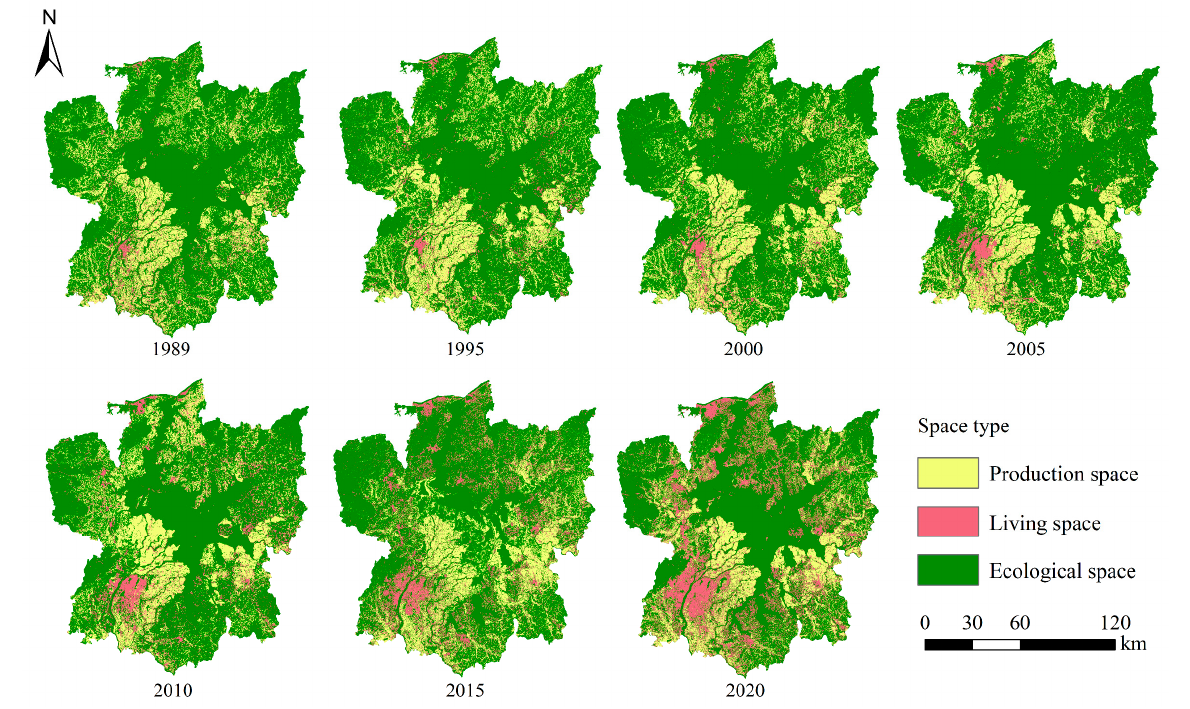
Figure 5. Spatial classification map of PLE space in the PYL area from 1989 to 2020. Table 5. Spatial transfer matrix in the PYL area from 1989 to 2020 (km 2 ).